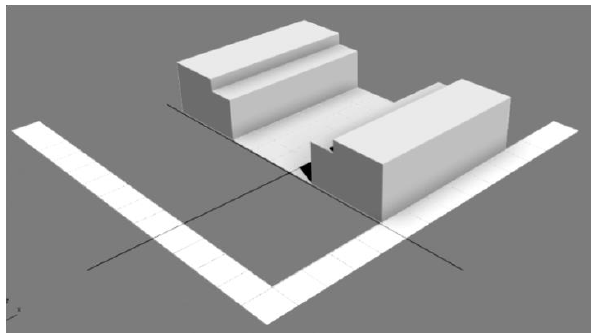
Figure 3. Middle lot layout. Gradual constructive densification to form several courtyards